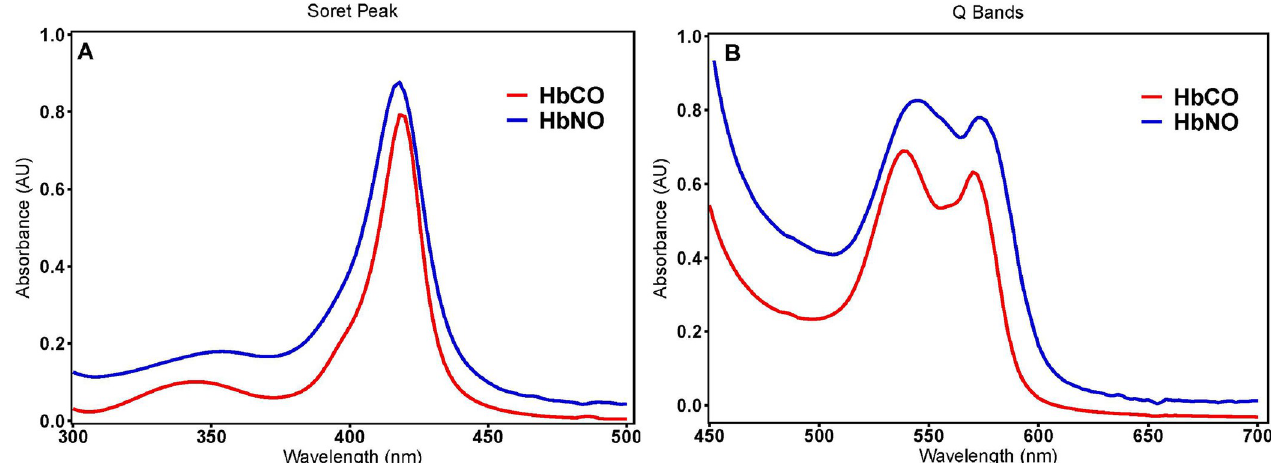
Fig 7. UV-visible spectroscopy of NO and CO bound cell free-Hb. (A) Soret and (B) Q Bands of NO and CO bound cell free-Hb measured were consistent with literature values, confirming PEG-LEH nanoparticle encapsulation of HbCO and HbNO.